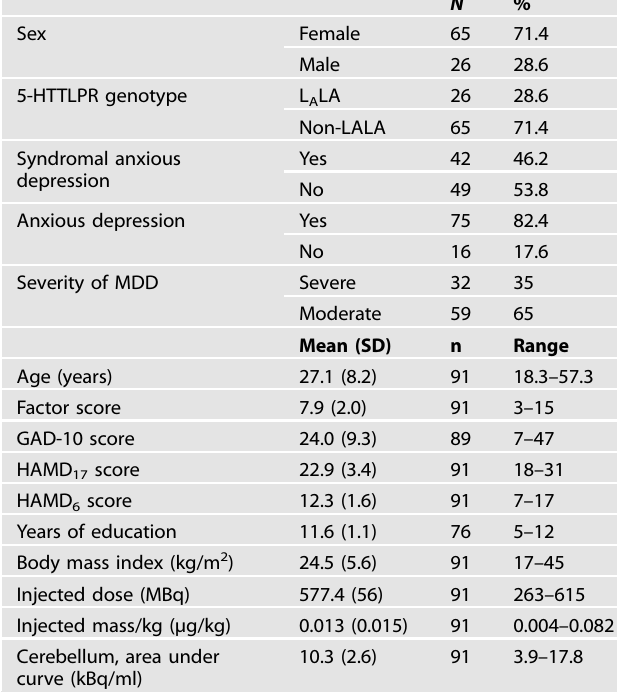
Table 1. Demographics and clinical pro fi le of patients at